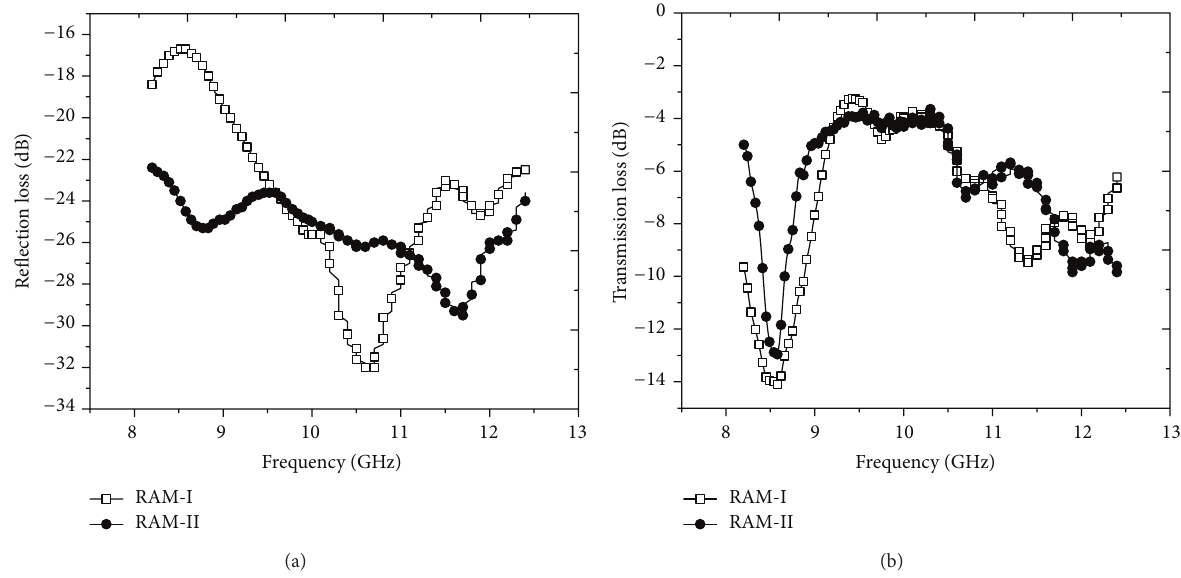
Figure 5: (a) Reflection loss (dB) versus frequency (GHz). (b) Transmission loss (dB) versus frequency